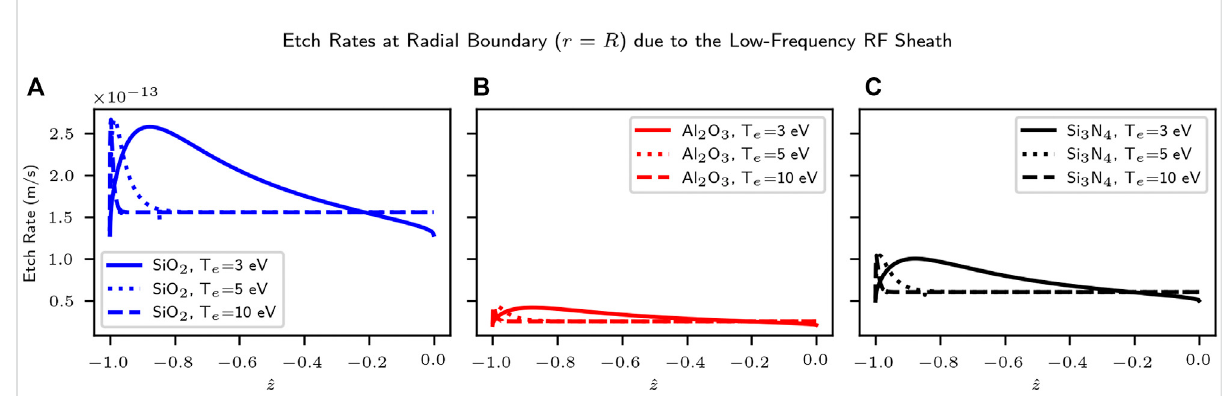
FIGURE 10 Estimation of the etch rate atthe radial boundary r = R , the inner surface of the dielectric cylinder, due to thelow-frequency RFsheath induced by the vicinity of the straps of the helicon antenna, using a method derived from the approach by Berisford et al. [3]. These plots represent the estimated etch rates for all possible locations of these external sources of RF excitation; actual devices typically have these antenna conductors at speci fi c particular locations. Results are presented for three different candidate materials ( SiO 2 , Al 2 O 3 , Si 3 N 4 corresponding to plots (A – C) ), and three values to of the electron temperature T e